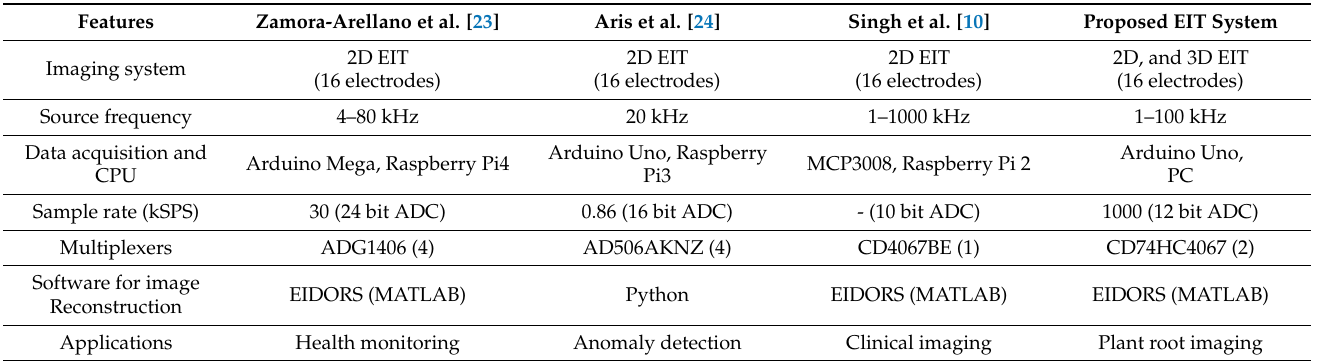
Table 3. A comparison of the features of proposed EIT data acquisition system with the previous research